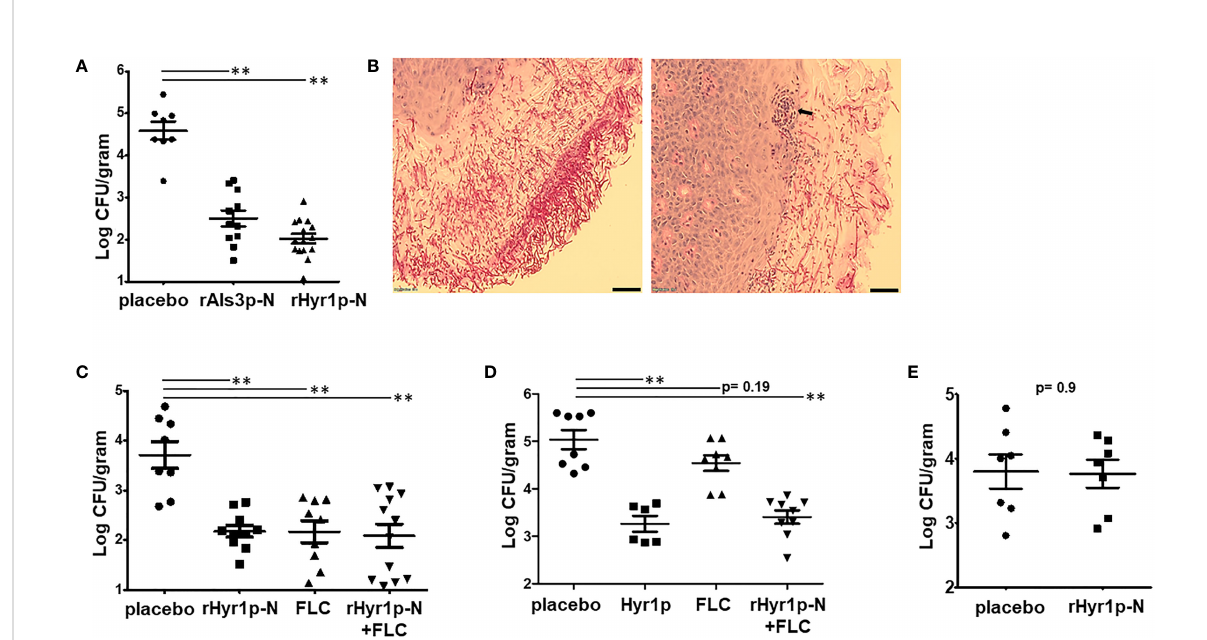
FIGURE 2 Passive vaccination by rAls3p-N or rHyr1p-N antisera protect pups from candidiasis. (A) Fungal burden in kidneys harvested from pups infected with C. albicans on day 3 of birth, and treated with sera obtained from mice vaccinated with rAls3p-N, rHyr1p-N or adjuvant alone (placebo). Treatment was on day 0 (4 h post infection) and day 2 relative to infection. (B) Histopathology during systemic C. albicans infection in pups. Sections stained with PAS stain. Arrows indicate C. albicans hyphae invaded kidney tissues. Scale bar = 10 µm. (C) Kidney fungal burden in pups infected with a fl uconazole (FLC) sensitive strain SC5314 and treated with control placebo sera (n= 8 pups), rHry1p-N anti-sera (n= 10 pups), or FLC alone (n= 9 pups), or a combination of rHyr1p-N+FLC (n= 12 pups). (D) Kidney fungal burden in pups infected with a FLC resistant strain CA6 and treated with control placebo sera (n= 8 pups), rHry1p-N antisera (n= 6 pups), FLC alone (n= 8 pups), or a combination of rHyr1p-N + FLC (n= 9 pups). (E) Kidney fungal burden in pups depleted of neutrophils, infected with C. albicans and treated with either the sera from placebo vaccinated mice (n= 7 pups) or rHyr1p-N anti-sera (n= 7 pups). ** P < 0.01 treatment vs. placebo sera vaccinated